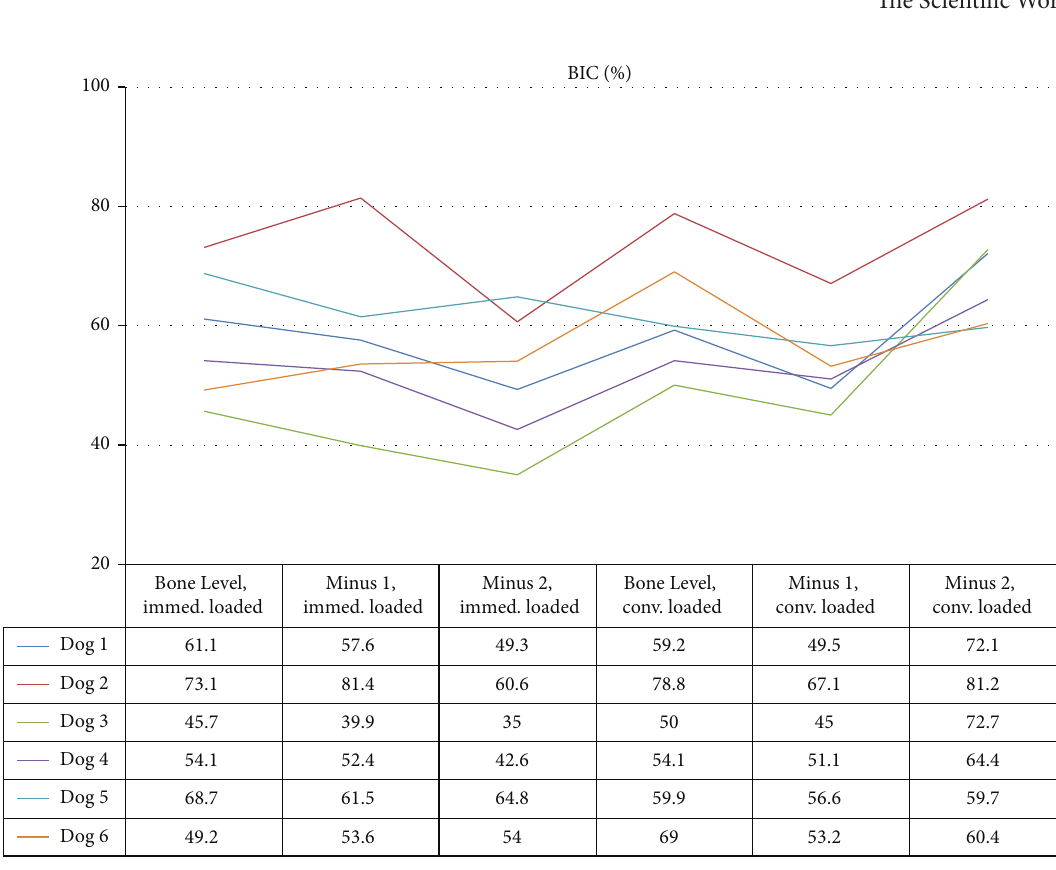
54.88±11.73. %, while those inserted at crestal level resulted in 42.52±8.67 %, 35.19±18.12 %, and 47.46±11.50 %, respectively. Differences between each subgroup in the test and the control groups were statistically